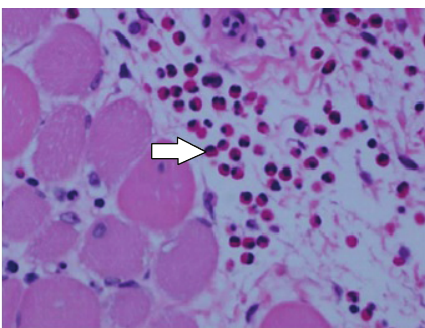
Figure 1: Cross section of skeletal muscle biopsy using H&E stain showing generalized myofiber atrophy with eosinophilic infiltrates (arrow) in the